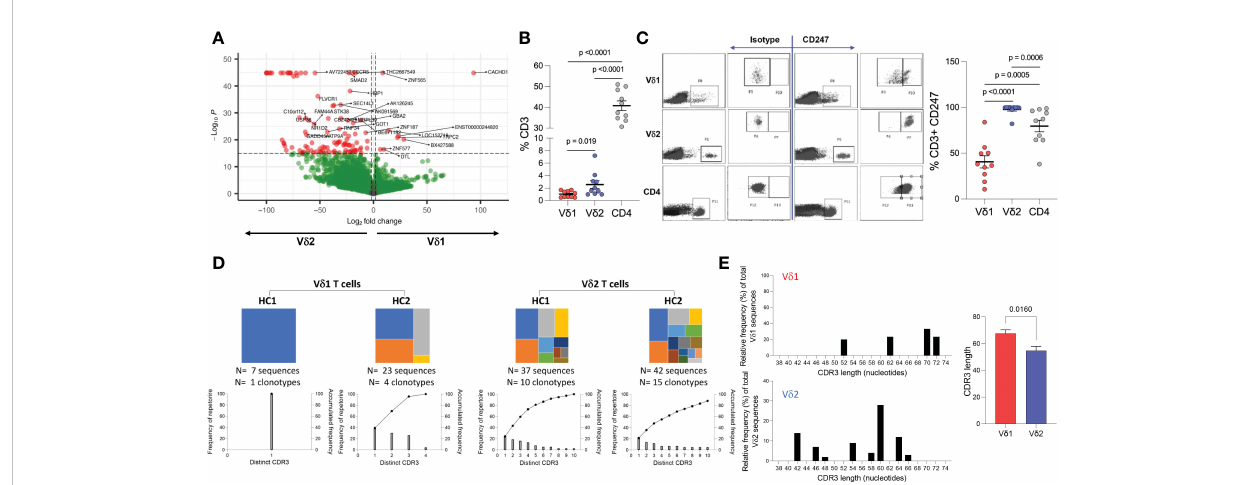
FIGURE 4 Whole genome and TCR sequencing. Ex vivo whole genome microarray data analysis of highly puri fi ed resting V d 1 and V d 2 T cells from four healthy donor volunteers. (A) Volcano plot displaying differentially expressed genes in V d 1 and V d 2 T cells (p<0.01 cut-off and 2-fold differential signal intensities). (B) Frequencies of V d 1, V d 2, and CD4 T cell amongst total CD3+ T cells in 10 donors used to corroborate (C) the differences in CD247 gene expression differences at the protein level by fl ow cytometry. (D) TCR repertoire sequencing in two healthy donor volunteers showing unique clonotypes as a proportion of the total repertoire (top panels). Lower graphs represent TCR occupancy of the top ten most frequent clonotypes. (E) Relative differences in CDR3 length usage amongst V d 1 and V d 2